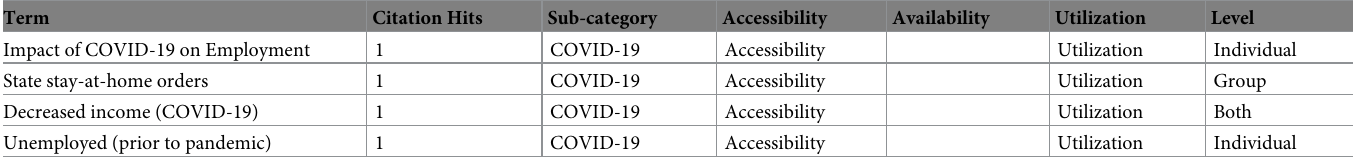
Table 6. COVID-19 related risk factors mapped to the dimensions of food